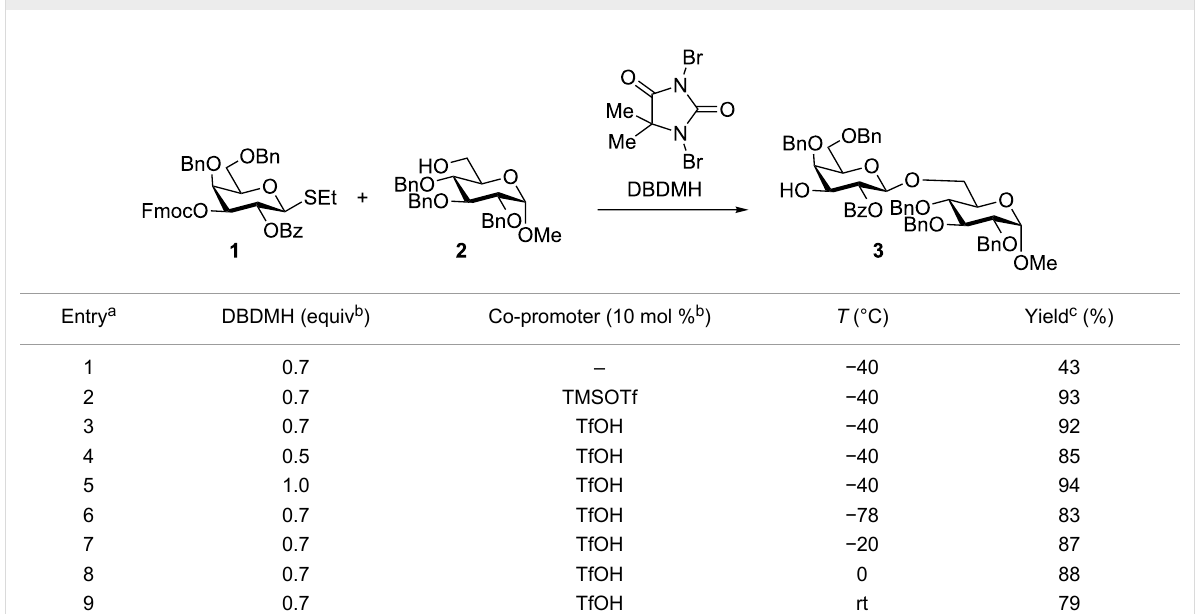
Table 1: Optimization of glycosylation conditions using DBDMH as